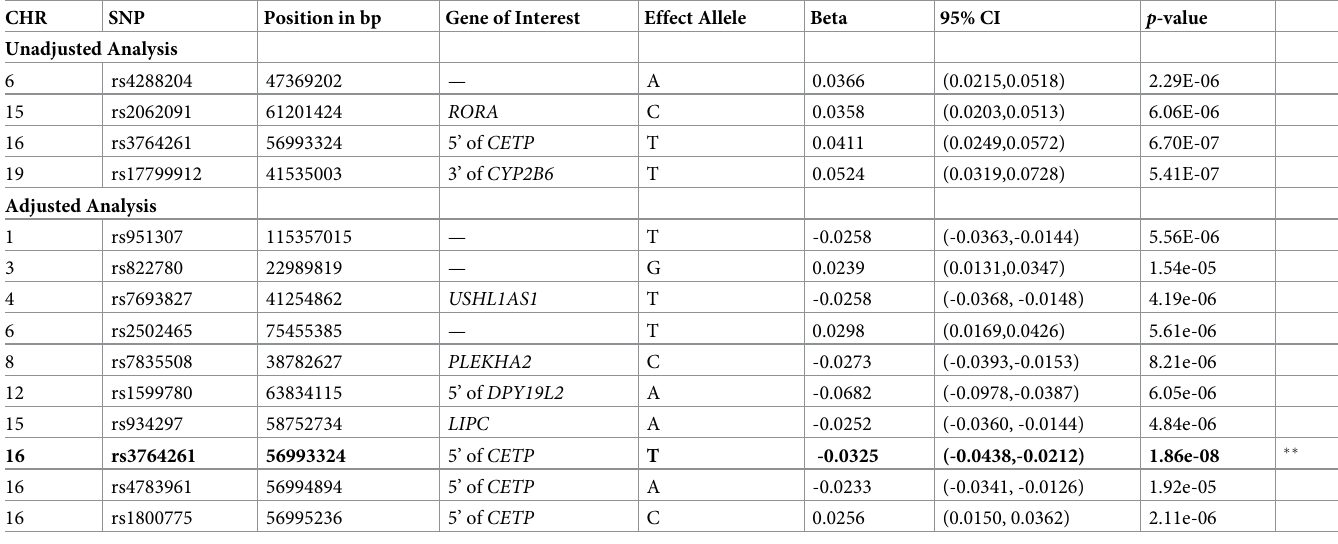
Table 2. Regression coefficients of significant SNPs from adjusted and unadjusted